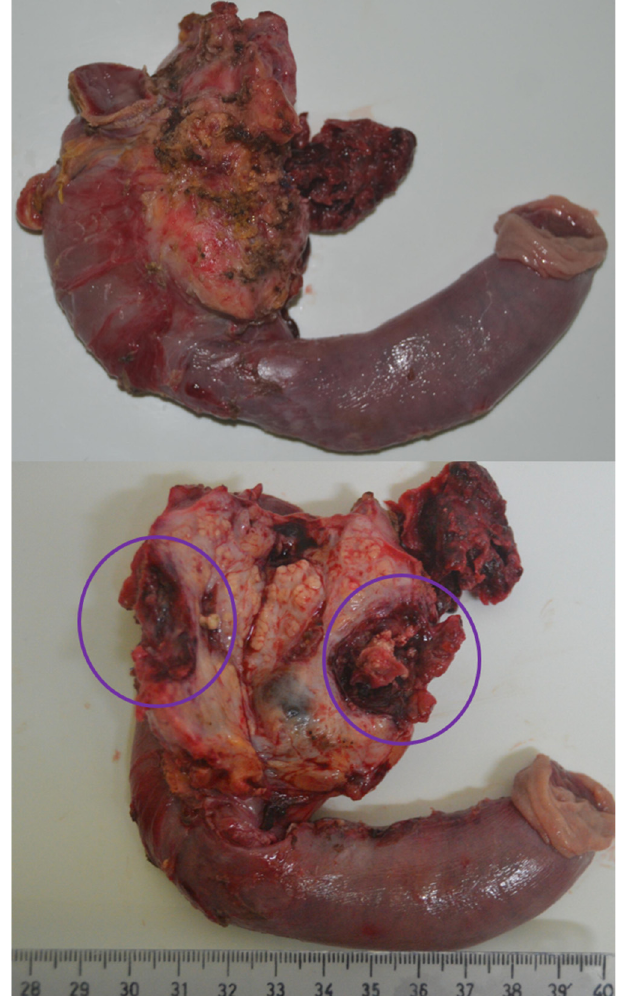
Figure 2. Resection specimen, with emphasis on the pseudoaneurysm of the pancreaticoduodenal artery.